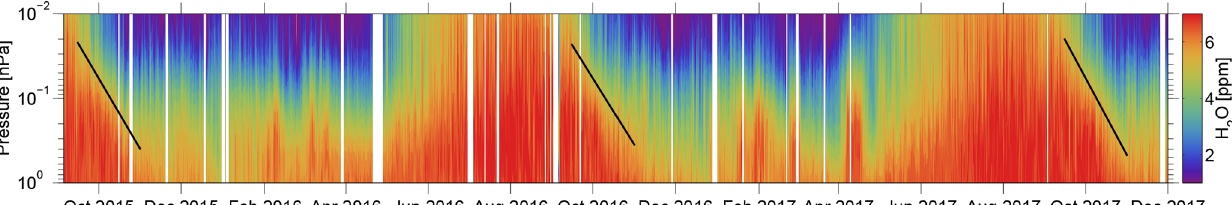
Figure 7. MIAWARA-C water vapour time series 2015–2017. The black line indicates the descent rate of water vapour within the polar vortex as derived from a linear fit of the 5.5ppm isopleth. The descent rates are 428md − 1 for 2015, 404md − 1 for 2016 and 468md − 1 for 2017.